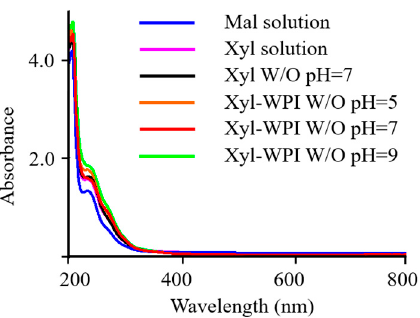
Figure 4. UV–vis spectroscopy of pigments from Beijing roast duck upon different treatments. Mal solution: 15% maltose solution; Xyl solution: 3% xylose solution; Xyl W/O: Emulsion stabilized by PGPR; Xyl-WPI W/O: Emulsion stabilized by PGPR and WPI; pH refers to the pH value of internal aqueous phase.